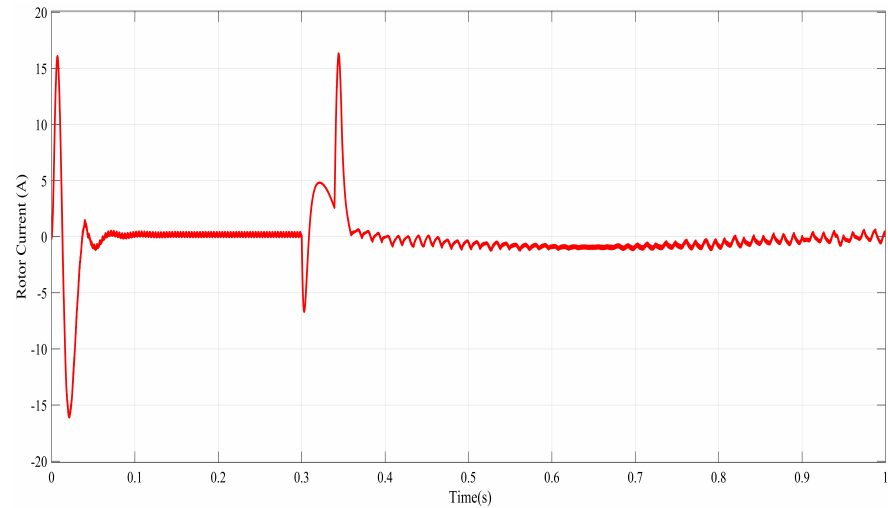
Figure 10. Rotor current response to varying load torque.